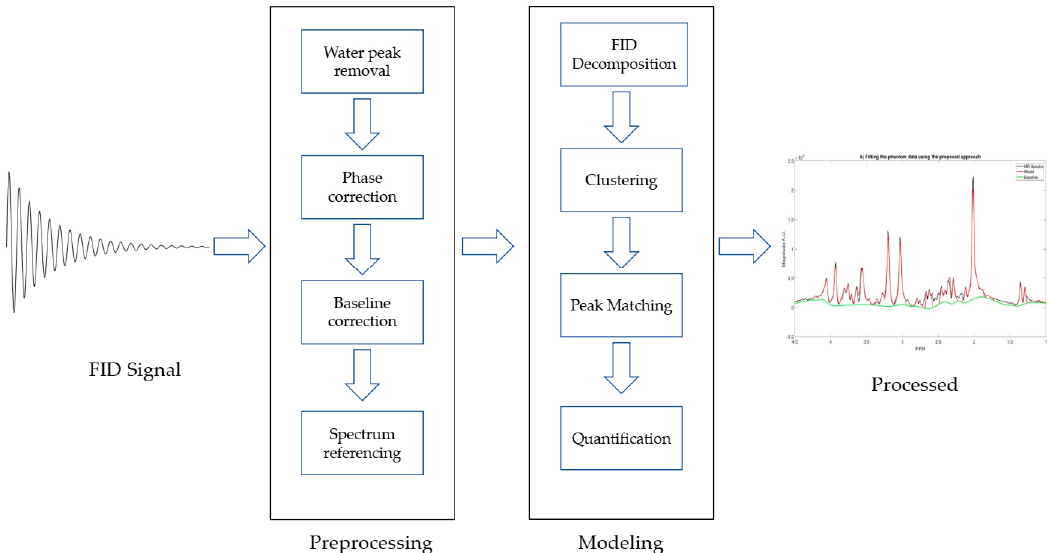
Figure 1. Diagrammatic representation of preprocessing and modeling steps for metabolite concentration quantification using magnetic resonance spectroscopy